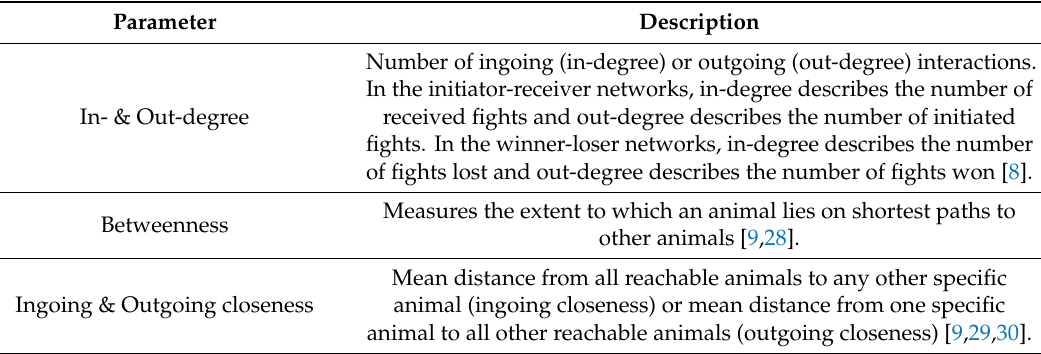
Table 2. Description of the calculated centrality parameters.